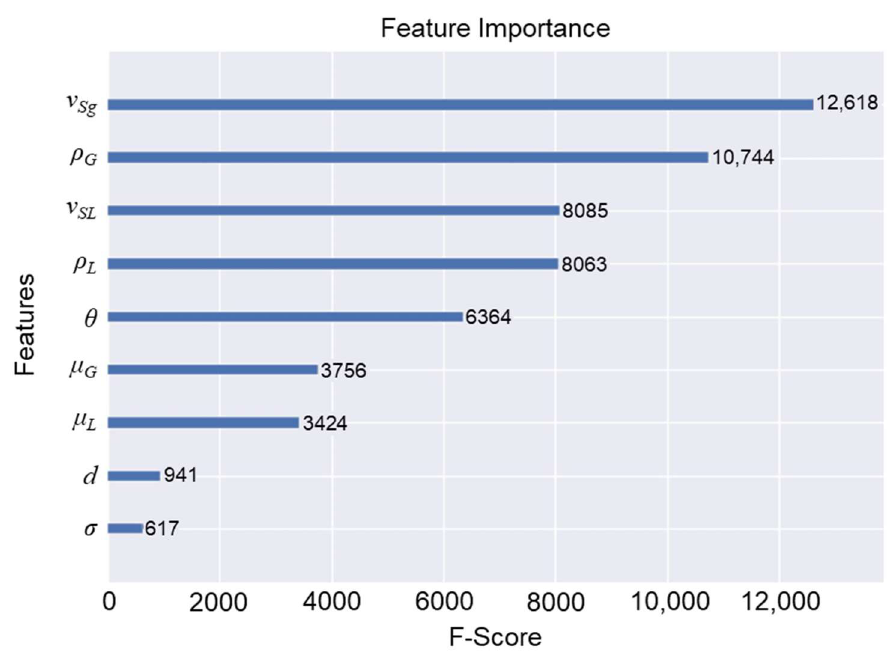
Figure 8. Feature importance of predictors determined using XGBoost.